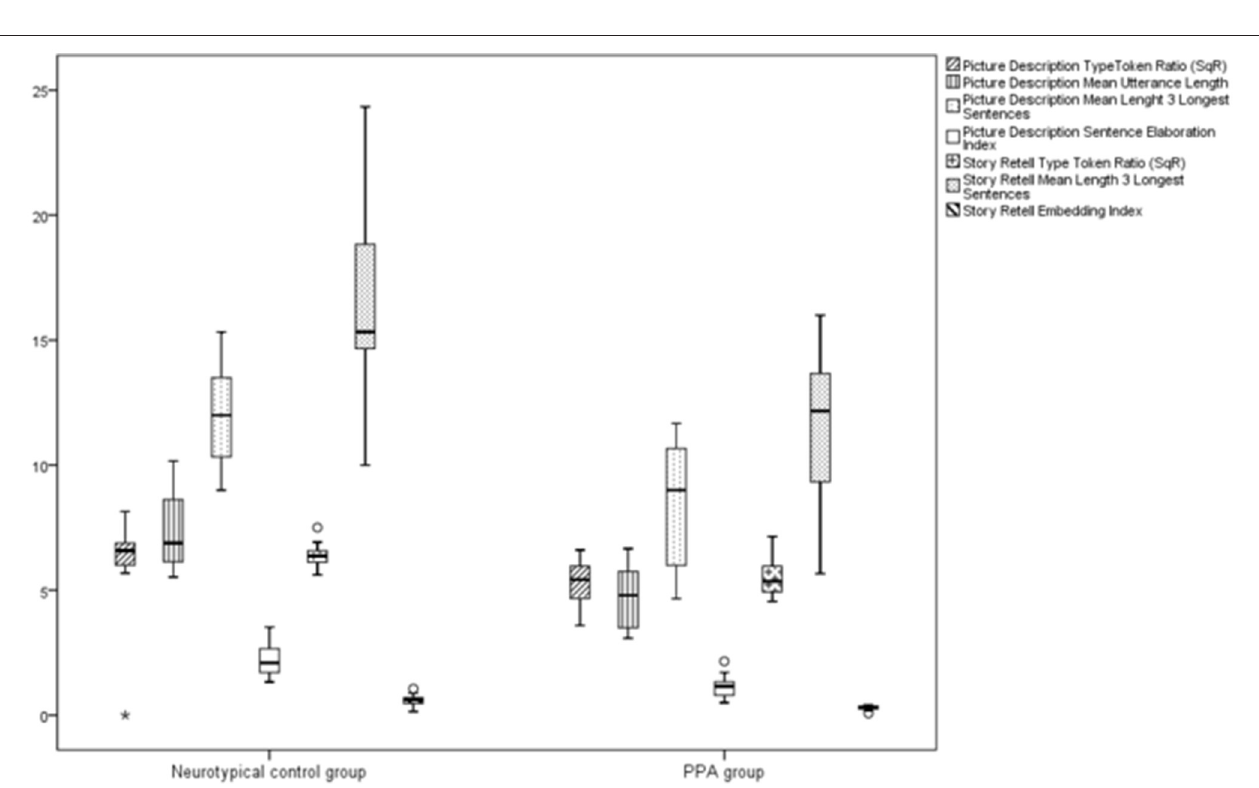
FIGURE 2 | Differences between individuals with PPA and neurotypical adults for narrative measures.